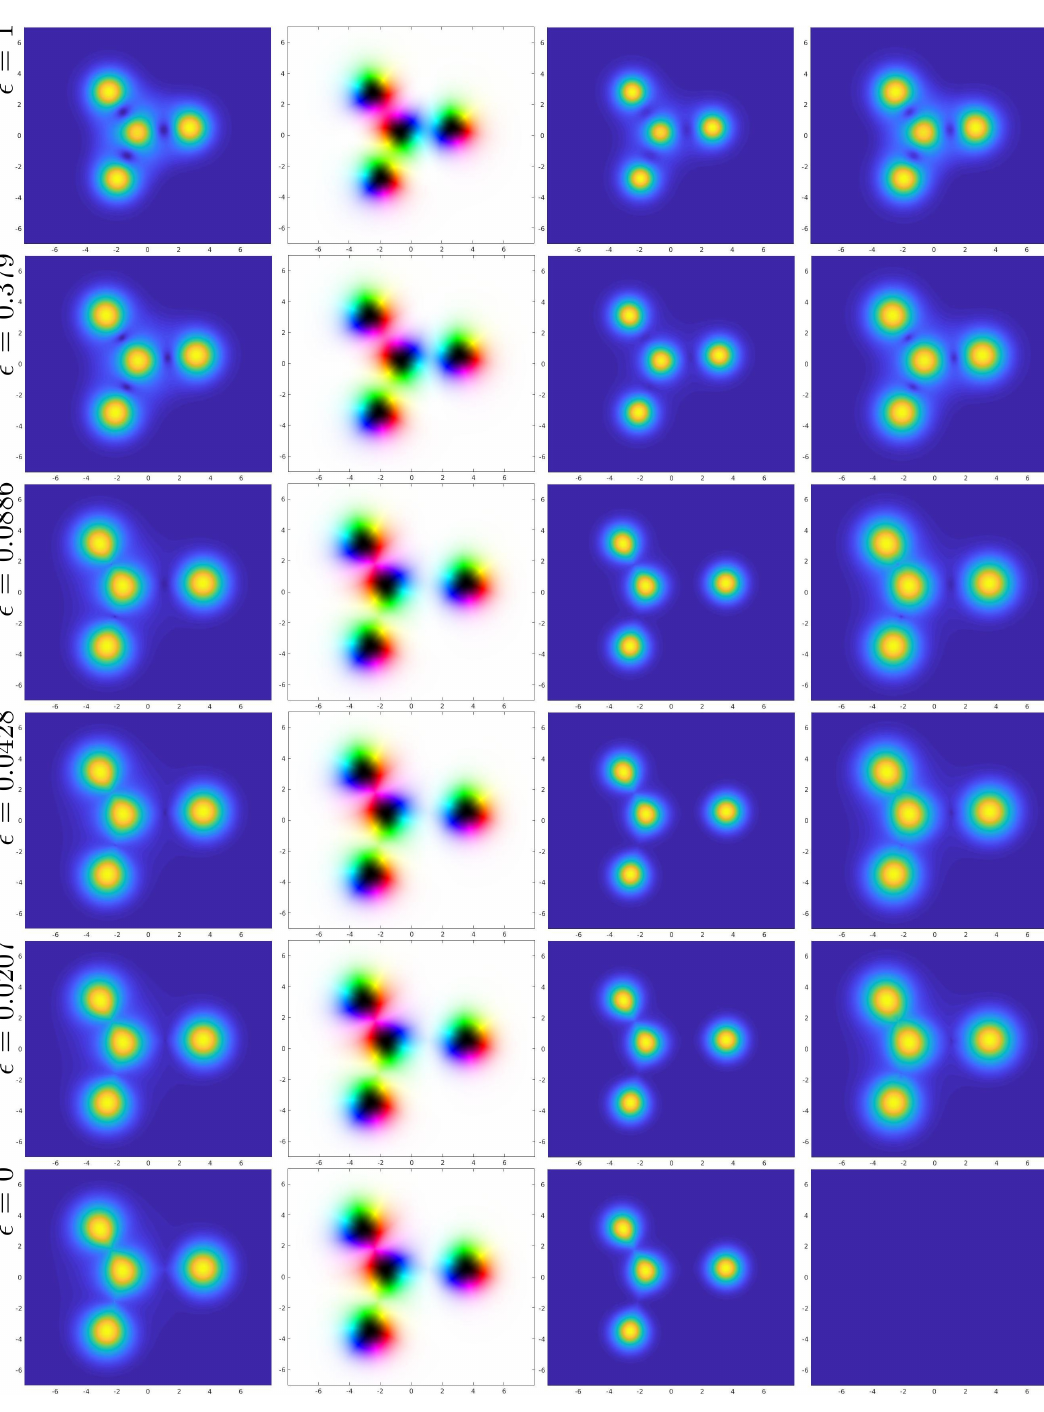
Figure 7. The Q = 1 + 1 + 1 + 1 baby Skyrmion with (almost) triangular symmetry, for various values of (cid:15) . The columns show the topological charge density, the pion vector orientation using a color scheme described in the text, the total energy density and the perturbation energy density (cid:15) ( −L 2 + m 2 V 1 ) . In this figure m 1 = 0 . 5 1